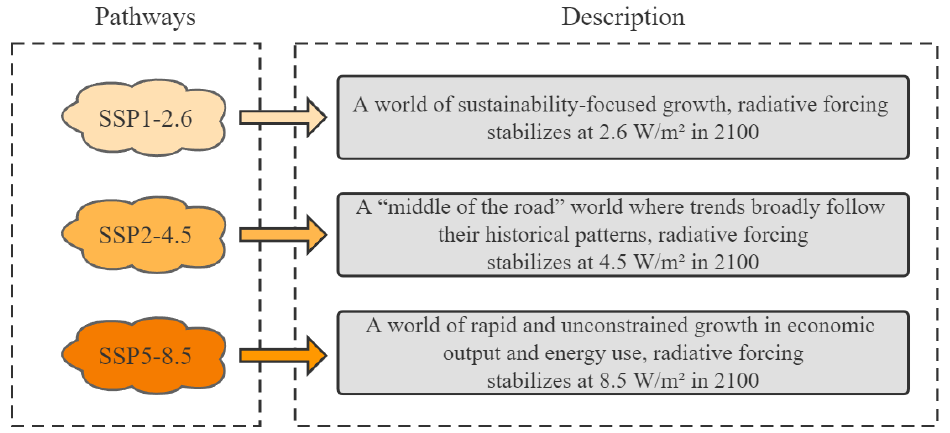
Figure 10. Descriptions of three shared socioeconomic pathways.